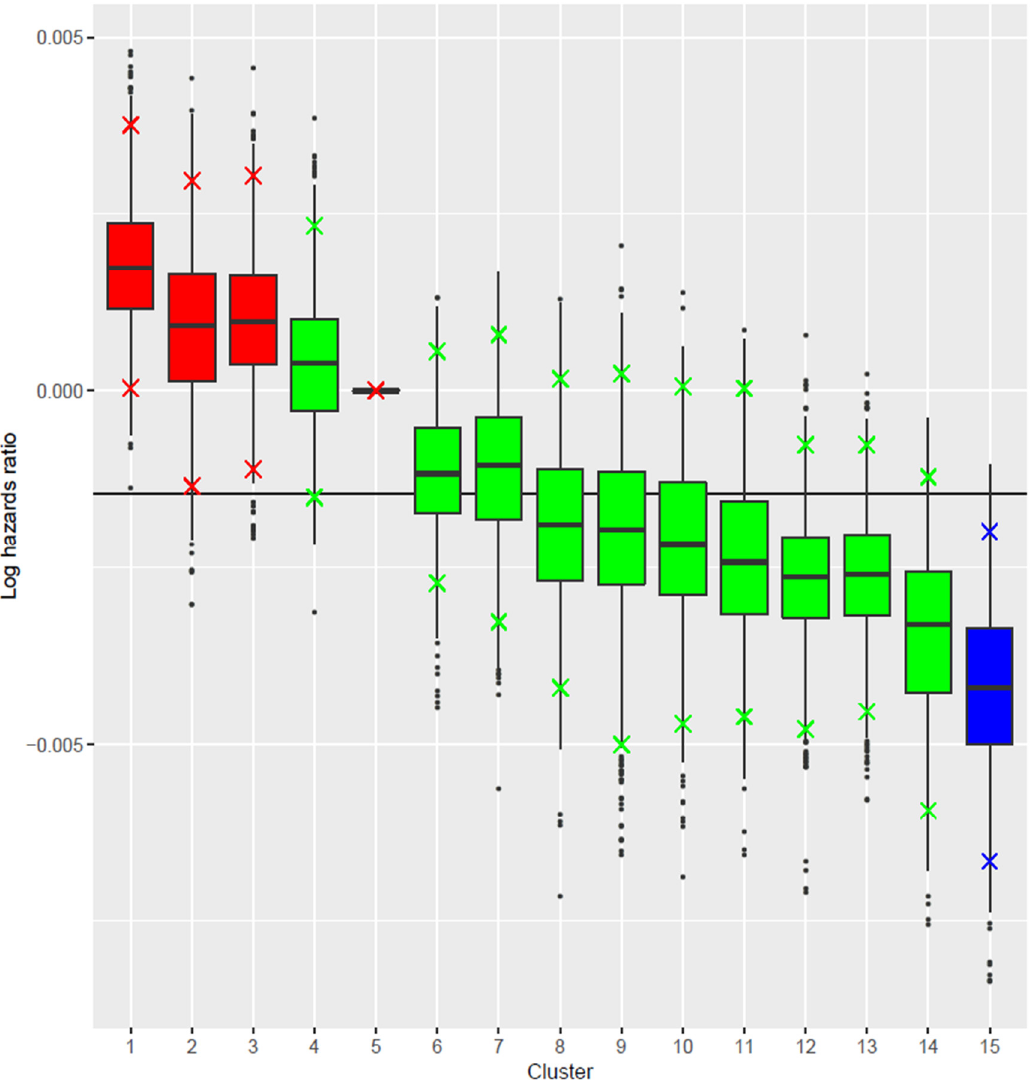
Figure 1. Log hazard ratios (logHRs) of clusters of polyphenol intakes profiles. The reference cluster is the largest cluster (cluster 5). The horizontal line represents the logHR mean for each analysis. The clusters whose 95% credible interval include the logHR mean are colored in green, and the rest in red for clusters at higher risk or blue for the cluster at lower risk.